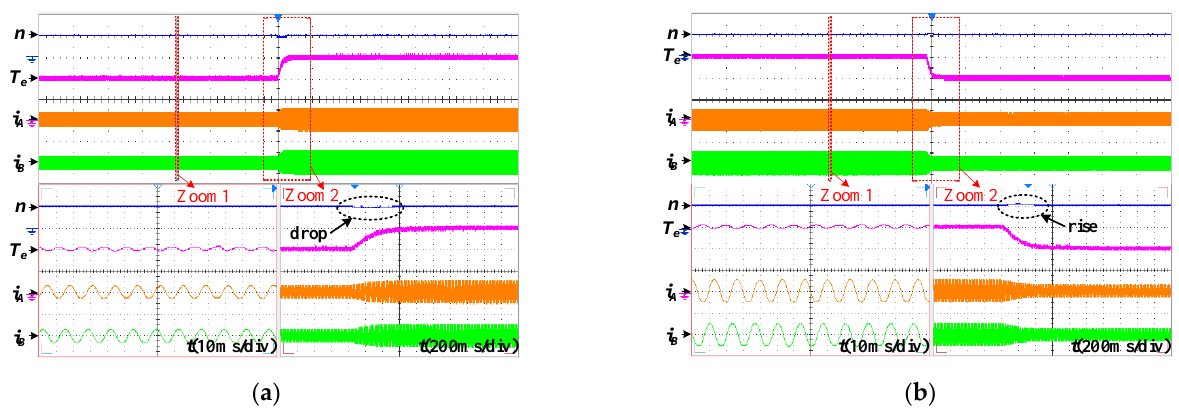
Figure 6. Dynamic responses with the changed load in healthy operation for the conventional FOC (500 rpm/div, 2 Nm/div, 5 A/div). ( a ) Increased load. ( b ) Reduced load.